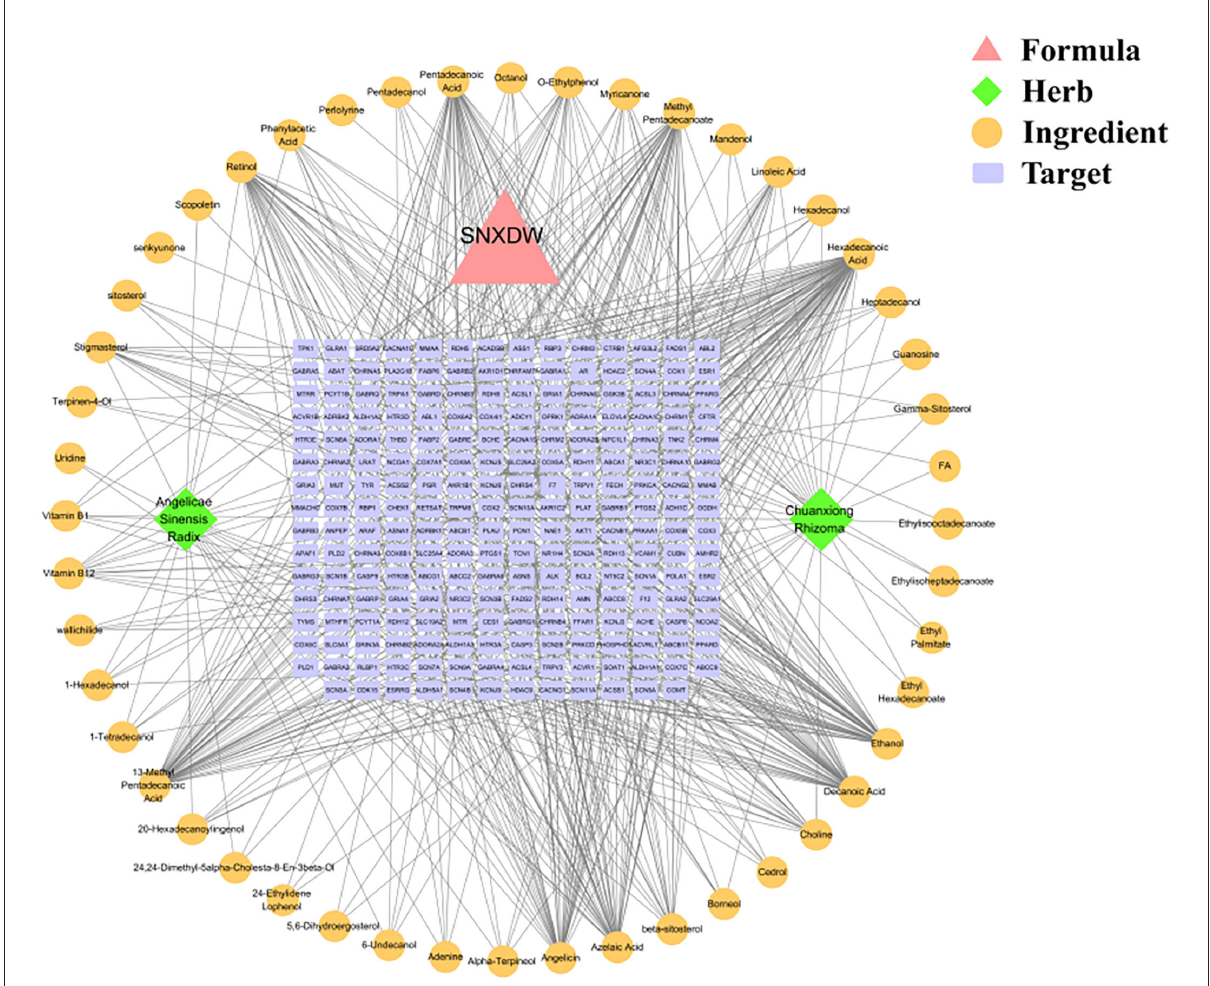
FIGURE1 Active ingredients of the Shunaoxin pill (SNXDW)-target gene PPI